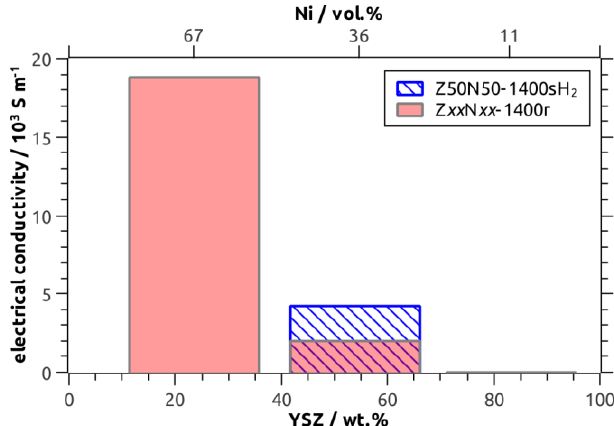
Figure 8. Electric conductivity of Ni–YSZ cermets as a function of the YSZ weight fraction/Ni volume fraction according to XRD with Rietveld analysis.